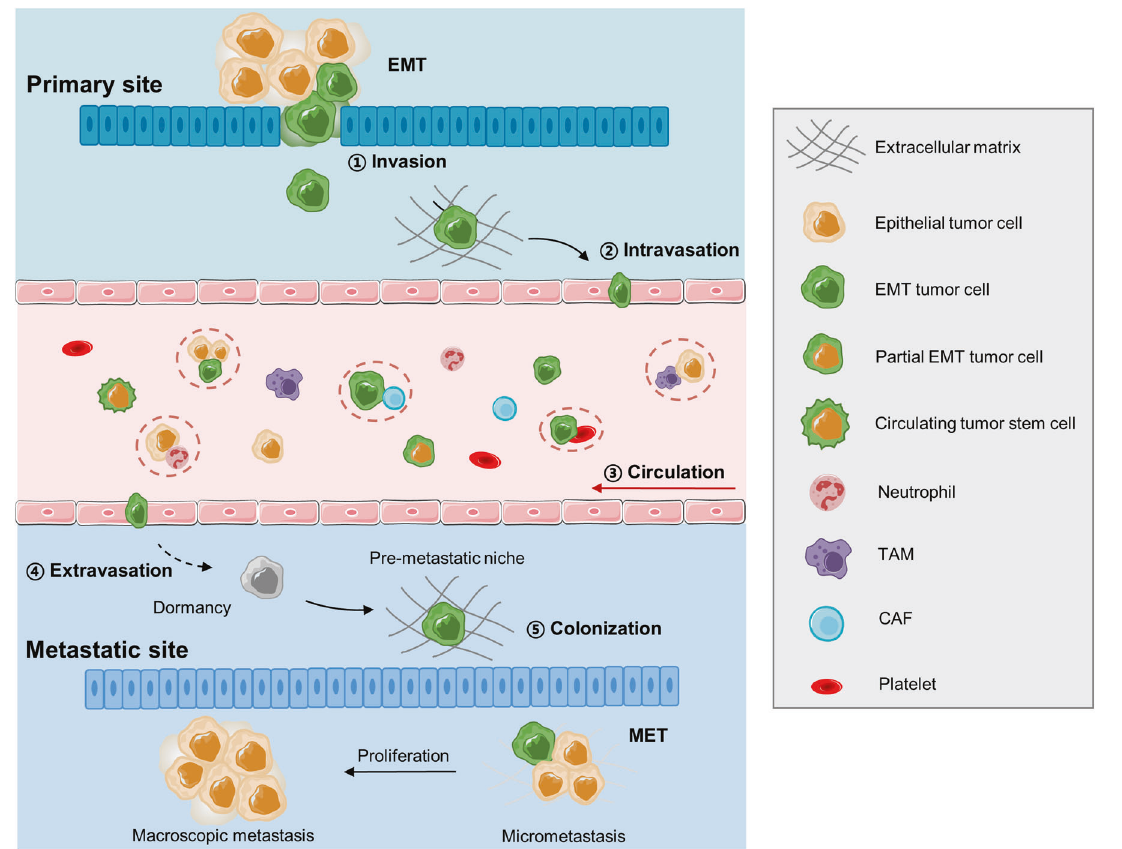
Fig. 2 Multistep process of cancer metastasis. The complex metastatic process includes tumor cell invasion in the primary site, intravasation into circulation, survival in the circulation as CTCs and interaction with blood cells, extravasation from the circulation, attachment to and colonization of the metastatic site. EMT: epithelial to mesenchymal transition, CAF: cancer-associated fi broblast, TAM: tumor-associated